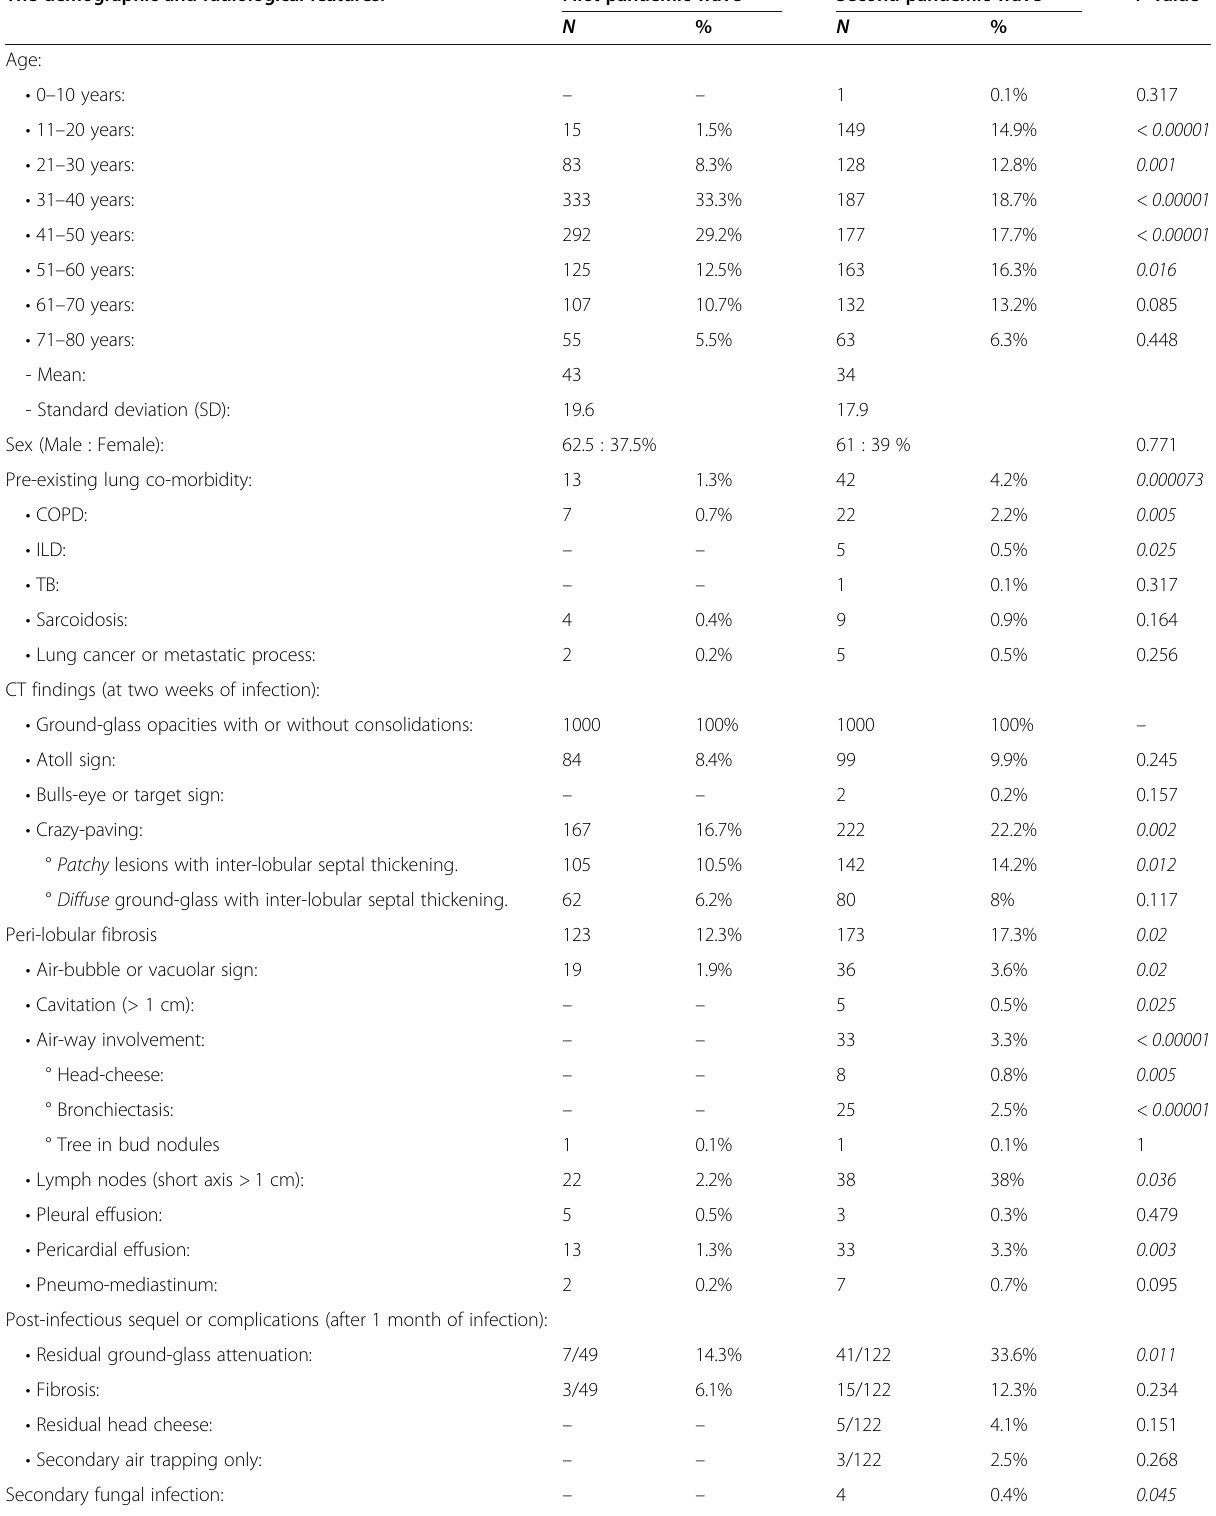
Table 1 Distribution of COVID-19 patients according to the demographic and radiological features in comparison between the first and second pandemic waves with statistical significance First pandemic wave Second pandemic